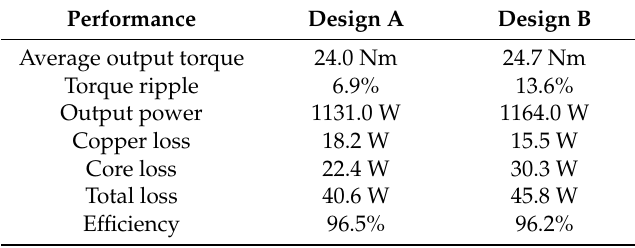
Table 7. Simulation results under light loaded condition (5 A maximum torque per ampere